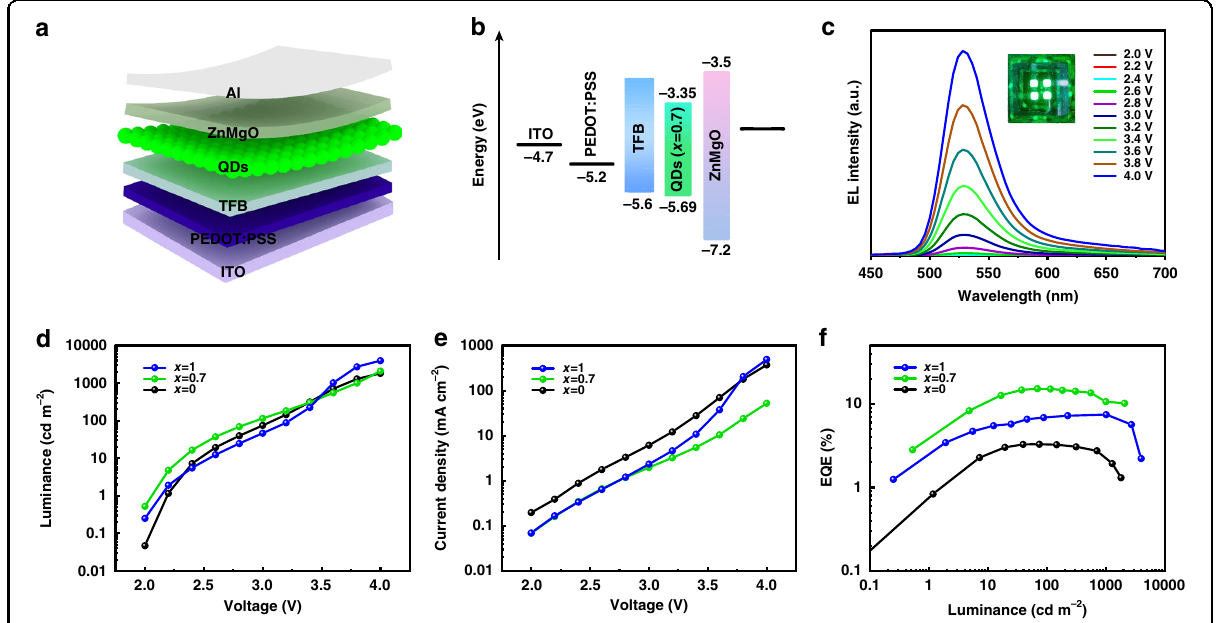
Fig. 5 Schematic of the device structure and EL performance of the InP/ZnSe x S 1 − x /ZnS ( x = 0, 0.7, 1) QLEDs. a Schematic of various layers in the device structure. b Energy band diagram of green-emitting InP/ZnSe 0.7 S 0.3 /ZnS QLEDs. c EL spectra. d Current density − voltage ( J − V ) characteristics. e Luminance − voltage ( L − V ) characteristics. f EQE as a function of